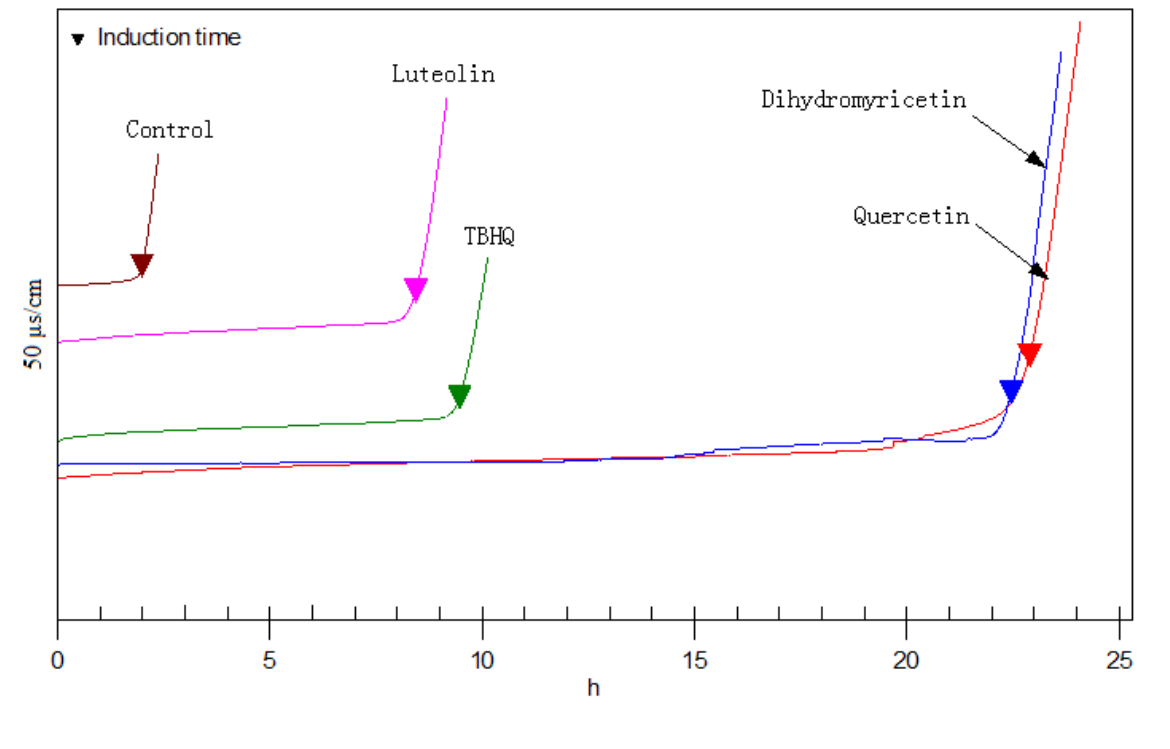
In conclusion, flavonoids inhibit oil oxidation by H-donation. The antioxidant performance of flavonoids could be explained by both Δ H and the number of hydroxyl groups in the conjugated B and f C ring